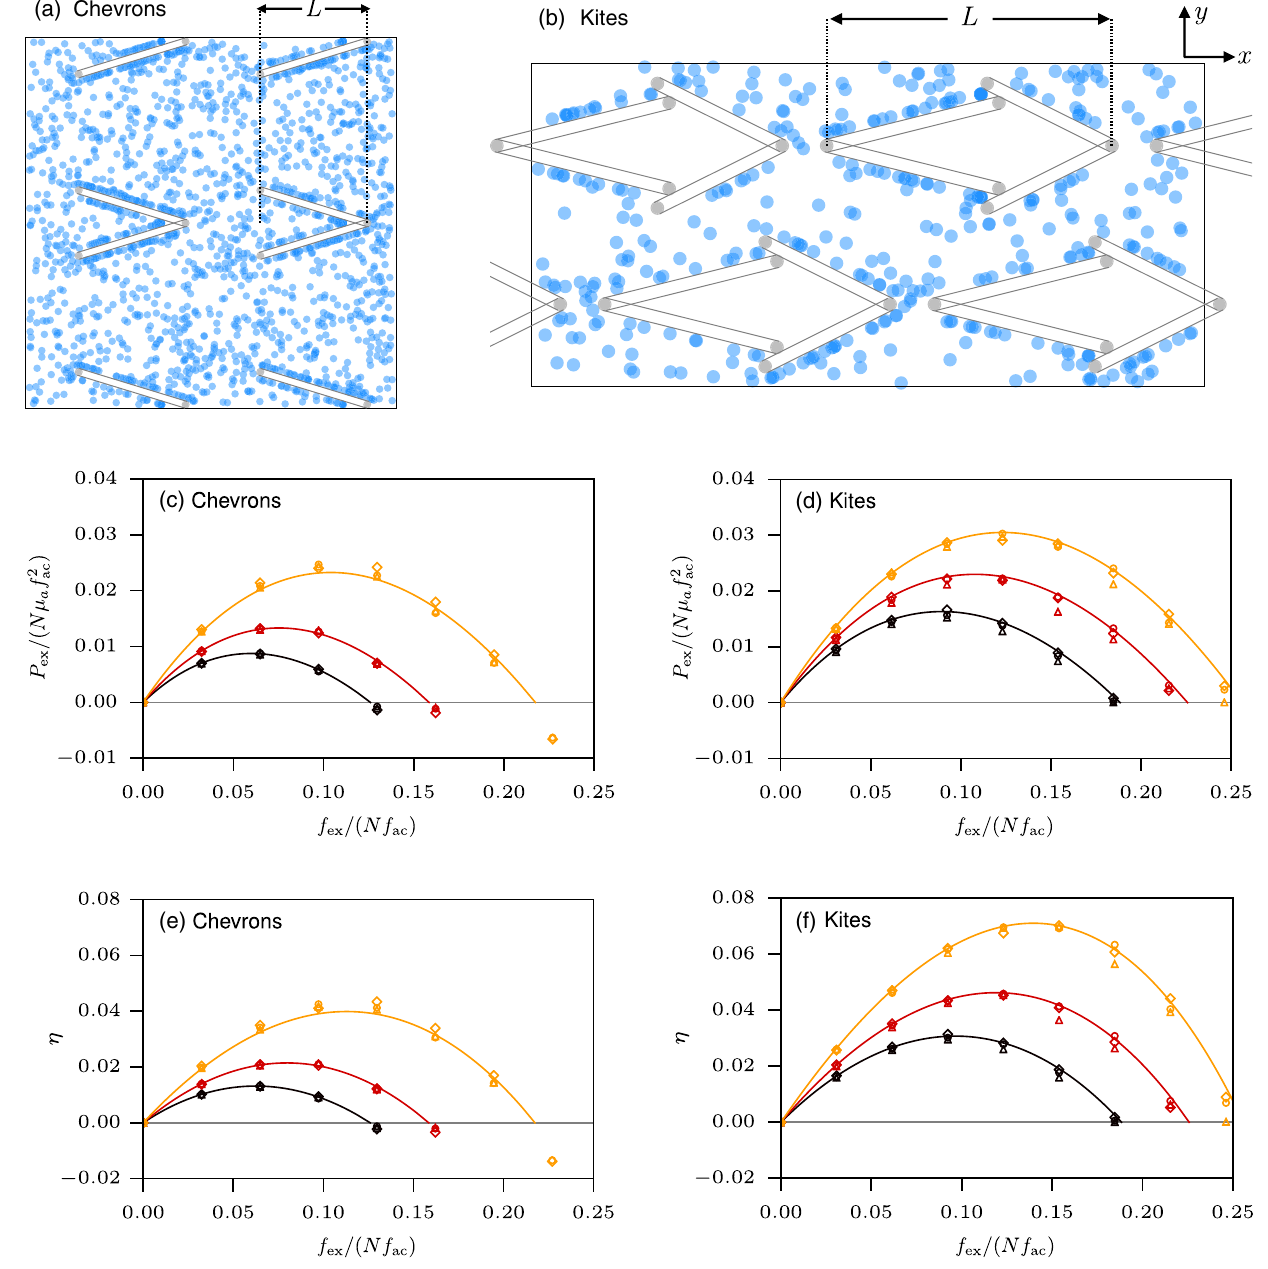
FIG. 7. Performances of autonomous engines in a bath of active particles. The engines are made of a series of asymmetric obstacles, either (a) chevrons or (b) kites, with a large axis denoted by L . The displacement of all obstacles is synchronized and restricted to the x axis. Active particles, shown as blue circles, interact only with the obstacles. Using a biperiodic box with size L x × L y and given the shape asymmetry, the obstacles follow a perpetual directed motion toward x > 0 . To extract work, the operator applies a constant force f toward x < 0 on the obstacles. The extracted power P ex kites as functions of the applied force. The shapes of the symbols refer to particle density ρ accounting for the excluded obstacle area: ρ ¼ 0 . 23 (triangles), 0.46 (circles), and 0.68 (diamonds). The color code corresponds to persistence lengths l ¼ μ particles. Chevrons: l =L ¼ 3 . 3 (black), 6.6 (red), and 66 (orange). Kites: l =L ¼ 2 . 2 (black), 4.4 (red), and 44 (orange). Solid curves are the predictions of the mean-field theory, obtained from simulations for a single active particle. Other parameters: D p ¼ 10 − 2 ¼ D a (except for chevrons at l =L ¼ 66 , where D p ¼ 1 ¼ D a ), f 52 × 25